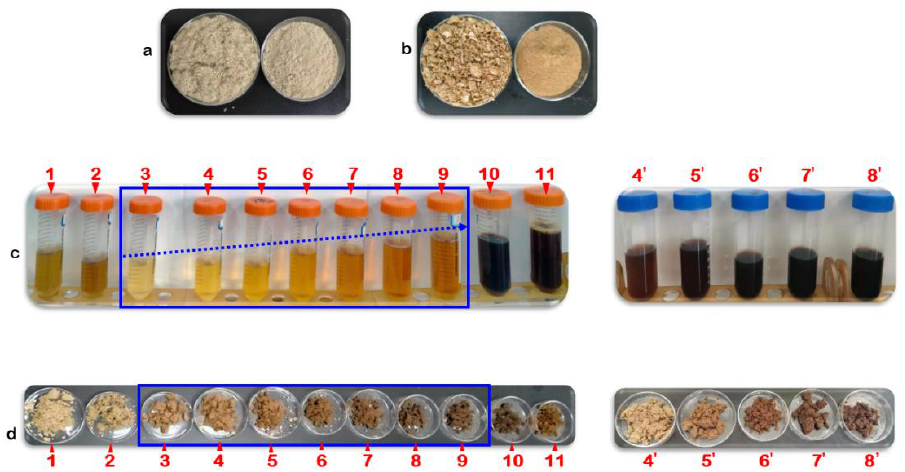
Figure 1. Photographs showing ( a ) SMS and ( b ) IHR raw materials, ( c ) hydrolysates, and ( d ) solid residues after